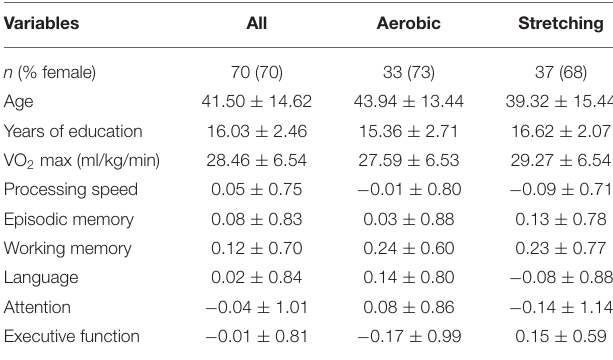
TABLE 1 | Baseline characteristics of the participants with longitudinal TRACULA